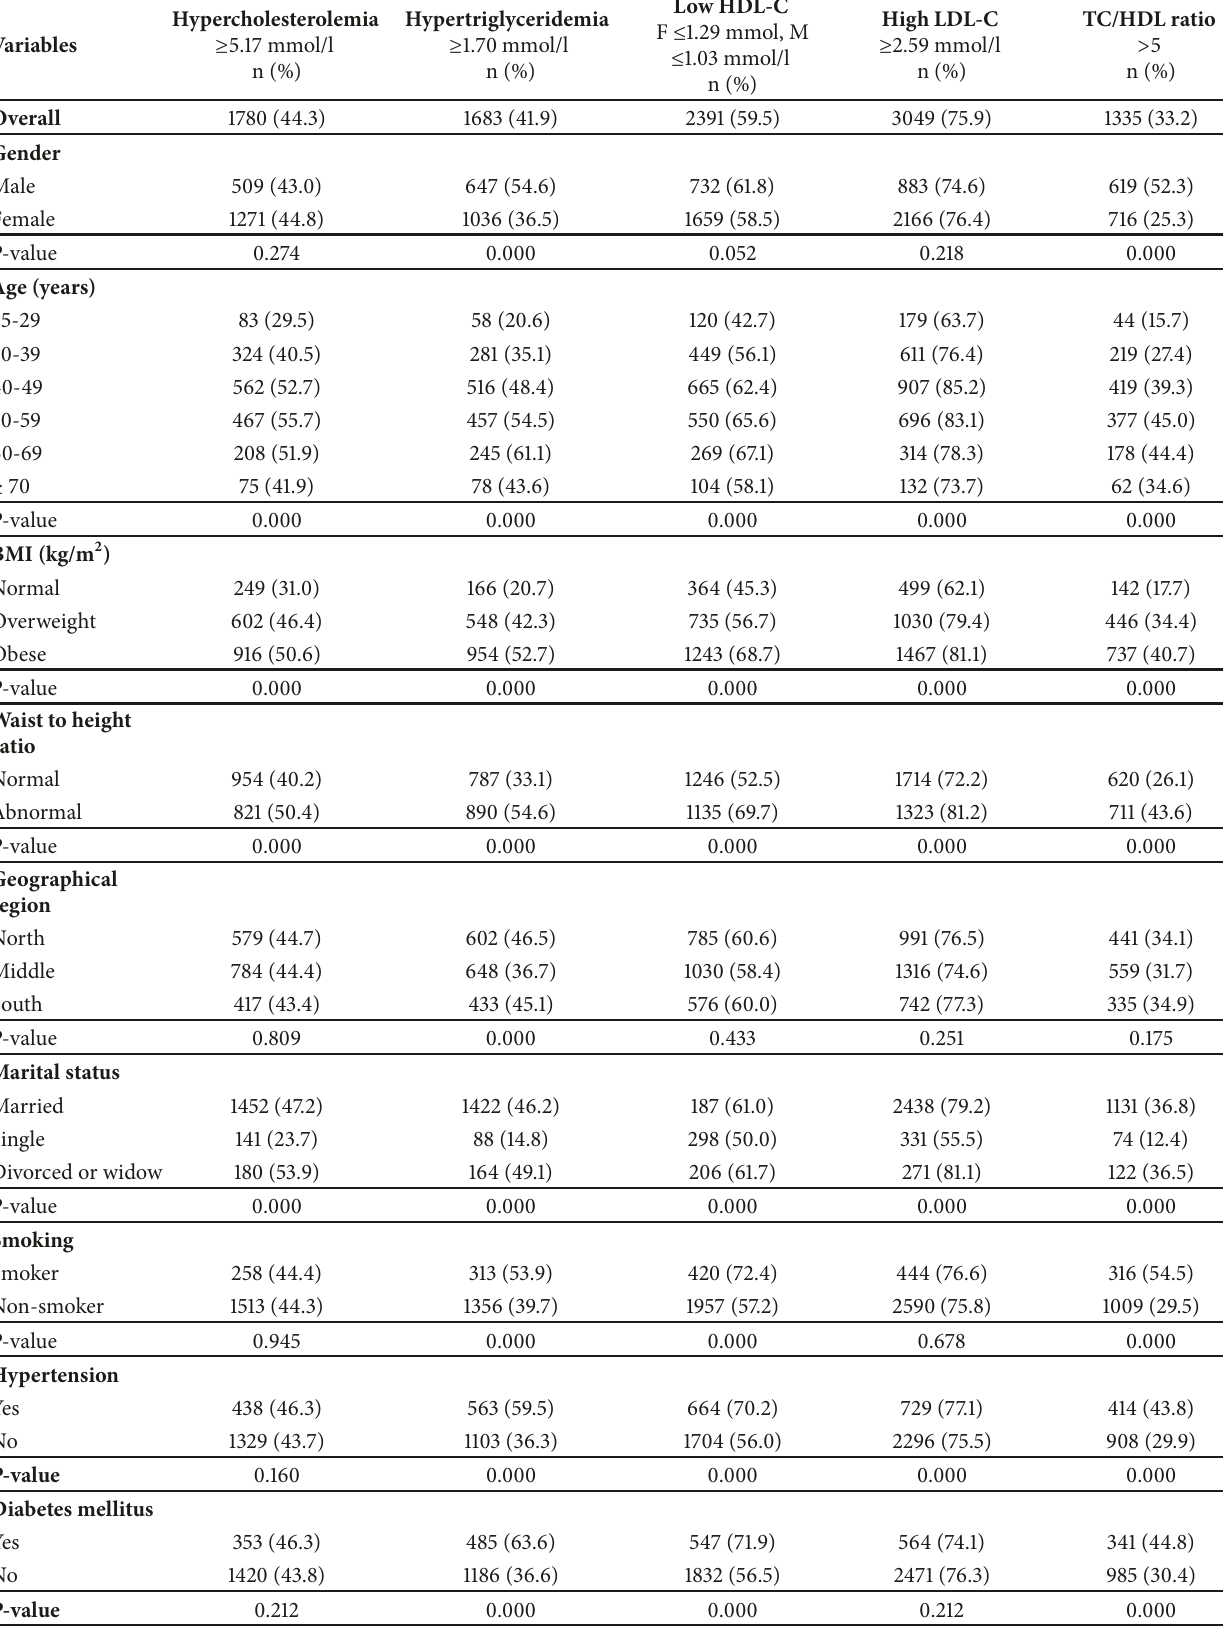
Table 1: Prevalence of dyslipidemia by selected variables, Jordan,